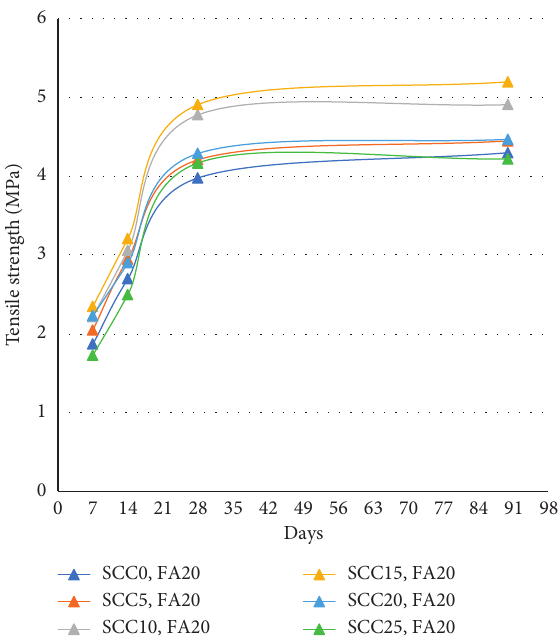
Figure 8: Tensile strength test results for concrete mixes with 20% replacement of fly ash.